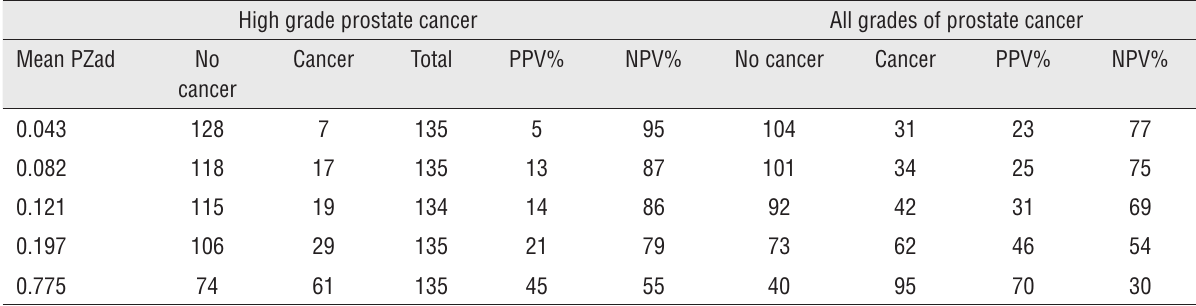
Table 3 - Positive and negative predictive values (PZad). High grade prostate cancer All grades of prostate cancer